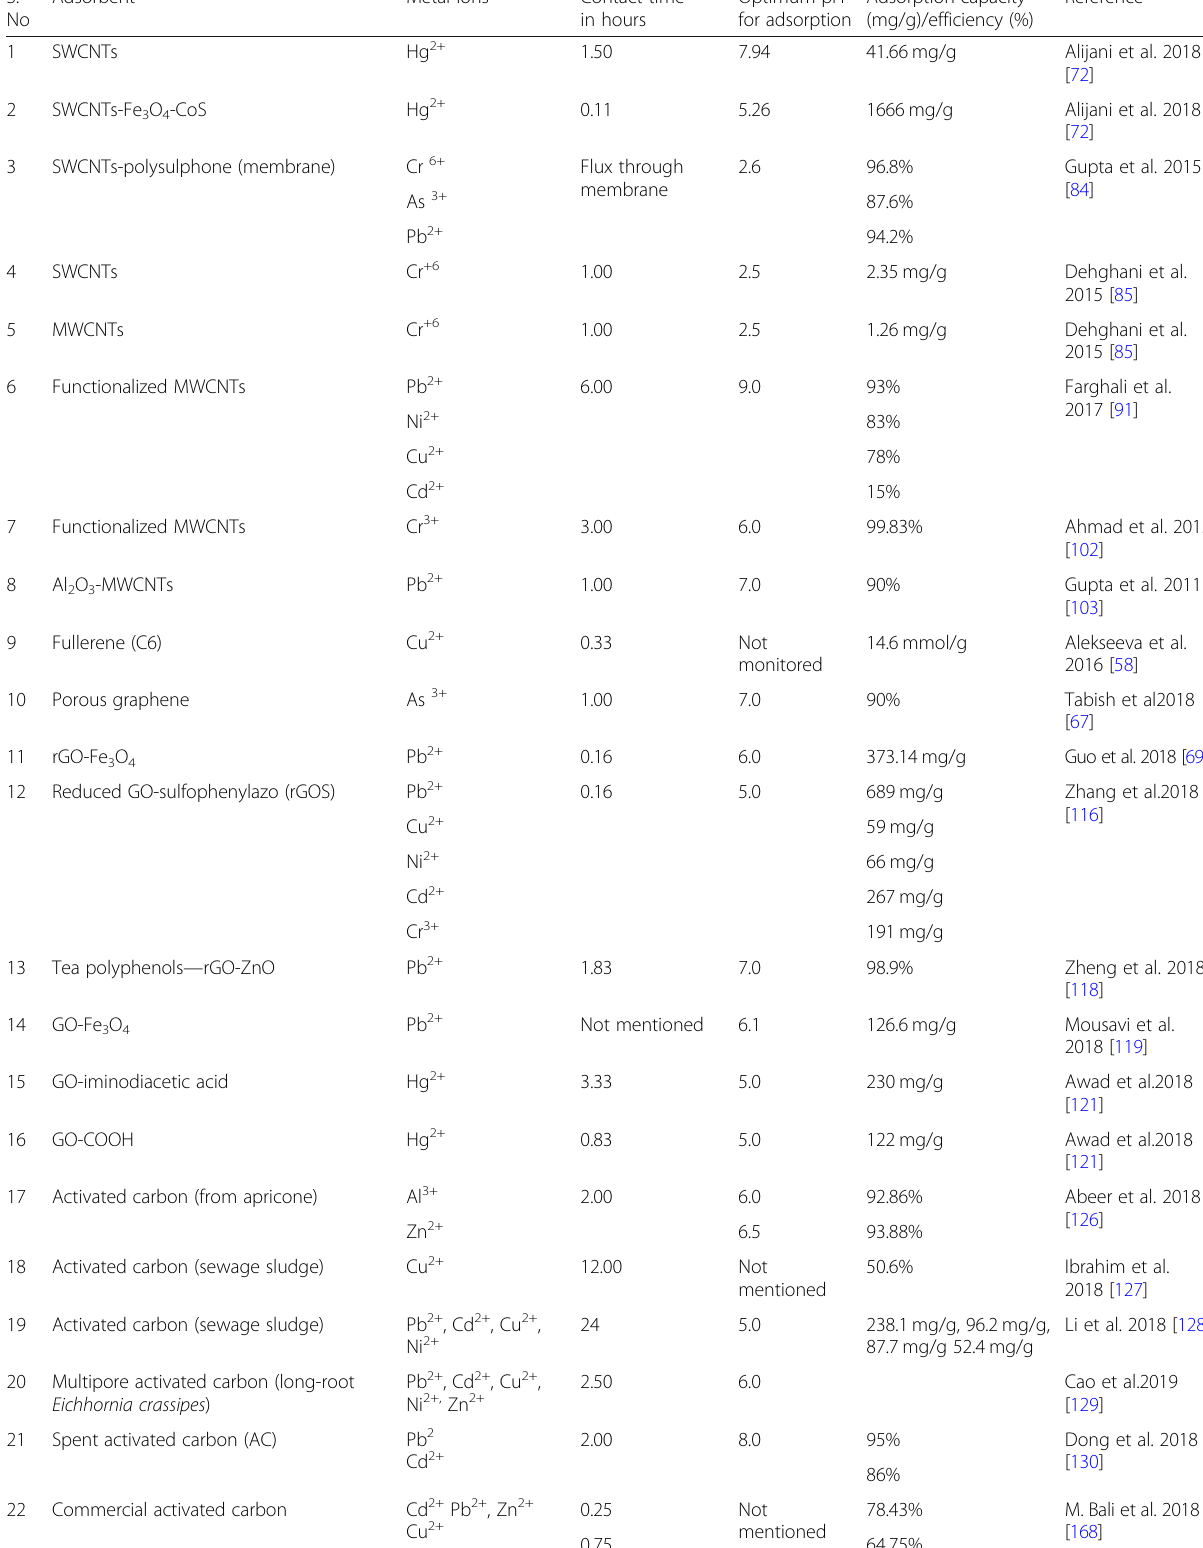
Table 2 Effect of different parameters on the process of metal ion adsorption S. No